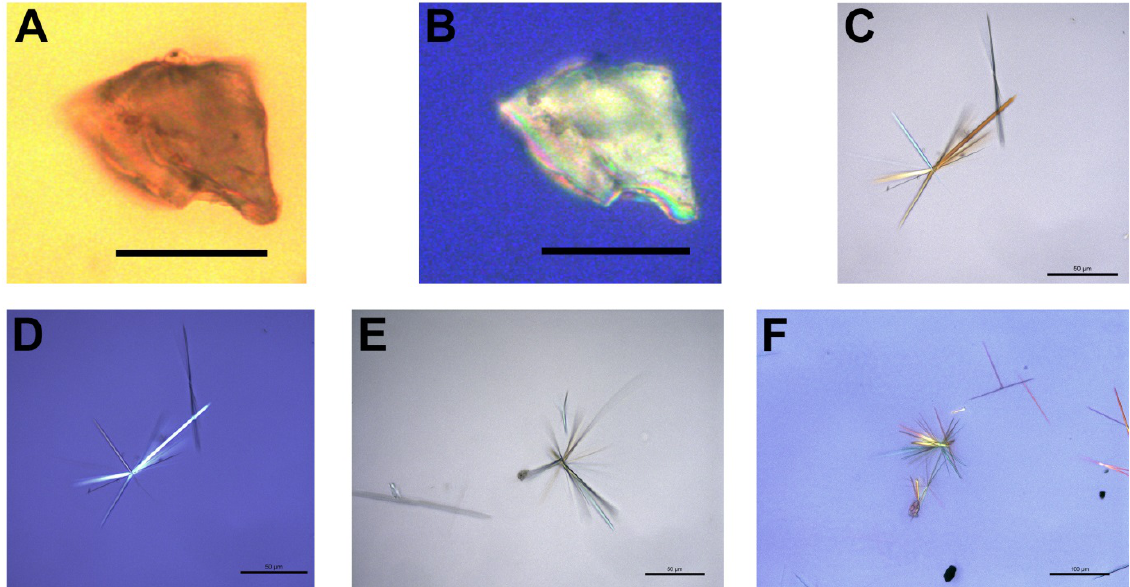
Figure 14. Various elements recovered from the sediment II of the distal part of the artifact. A-B: element 5. C- F: Series of raphides; C-D: Series 1, E: Series 2, F: Series 3. Photos taken under bright field (A,C,E) and polarized light (B,F). Scale bars: A-E, 50 µm; F, 100 µm. Photos by Rodrigo Angeles